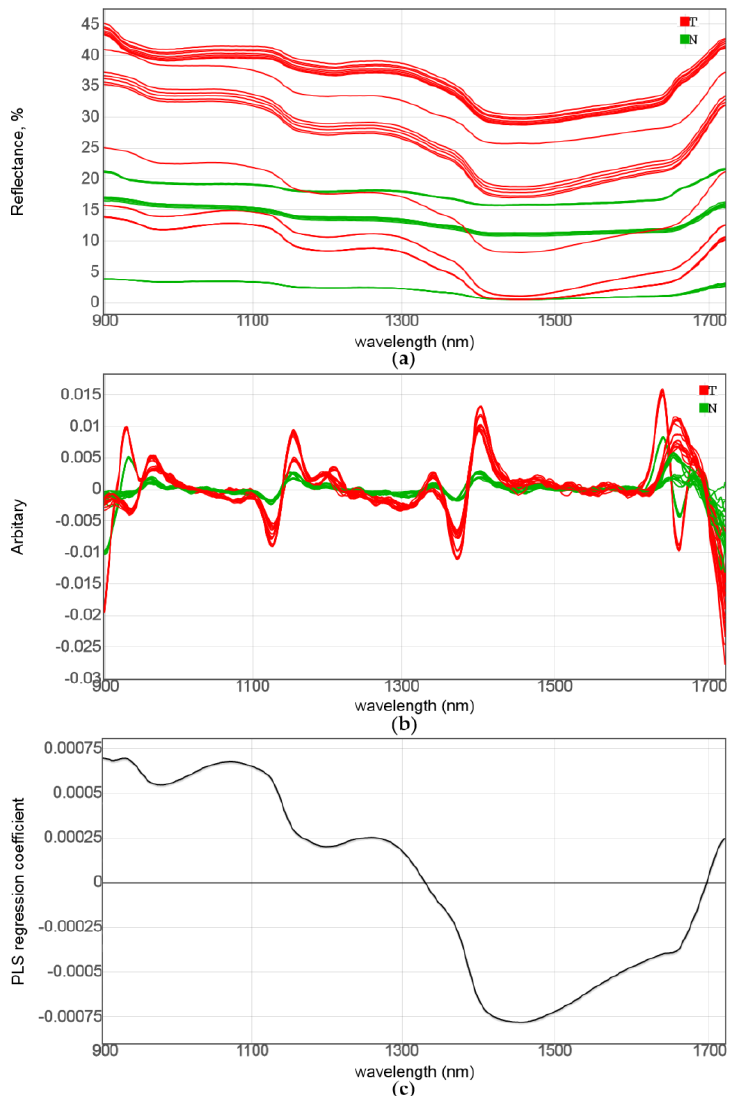
Figure 5. Analysis of near-infrared (NIR) spectra in Series A: ( a ) raw spectra, ( b ) second-derivative spectra, and ( c ) partial least-squares discriminant analysis (PLS-DA) regression coefficients. Red and green spectra in (a,b) correspond to tumor tissue and normal tissue, respectively.